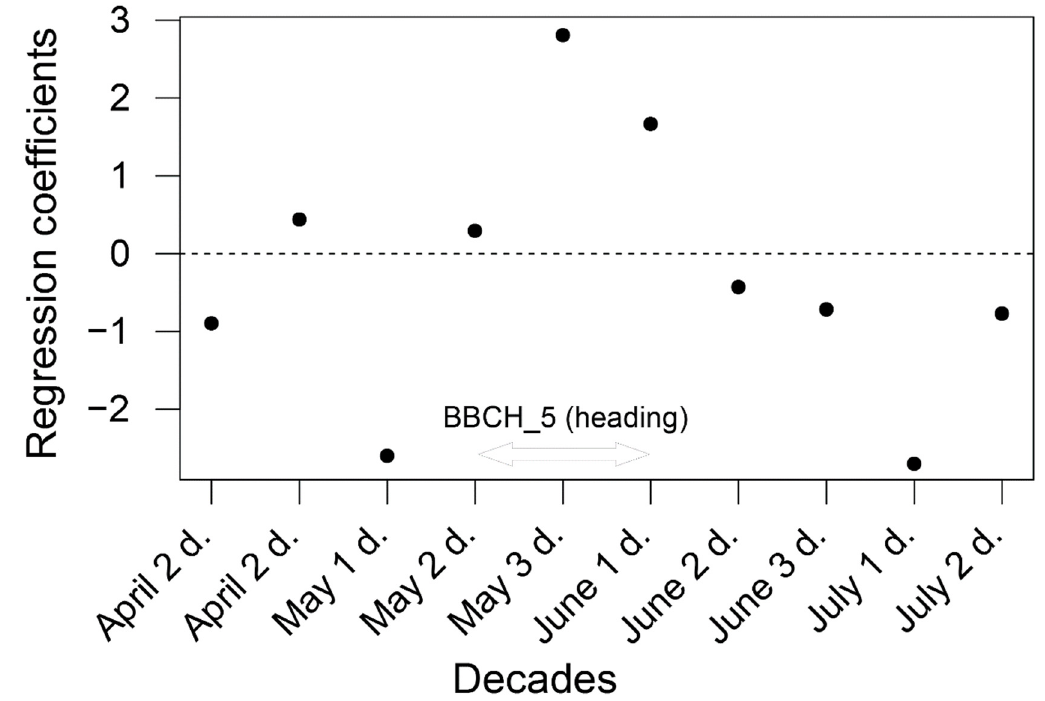
Figure 1. Regression coefficients of the effect of HTC on winter wheat yield in 10-day periods included in the study.